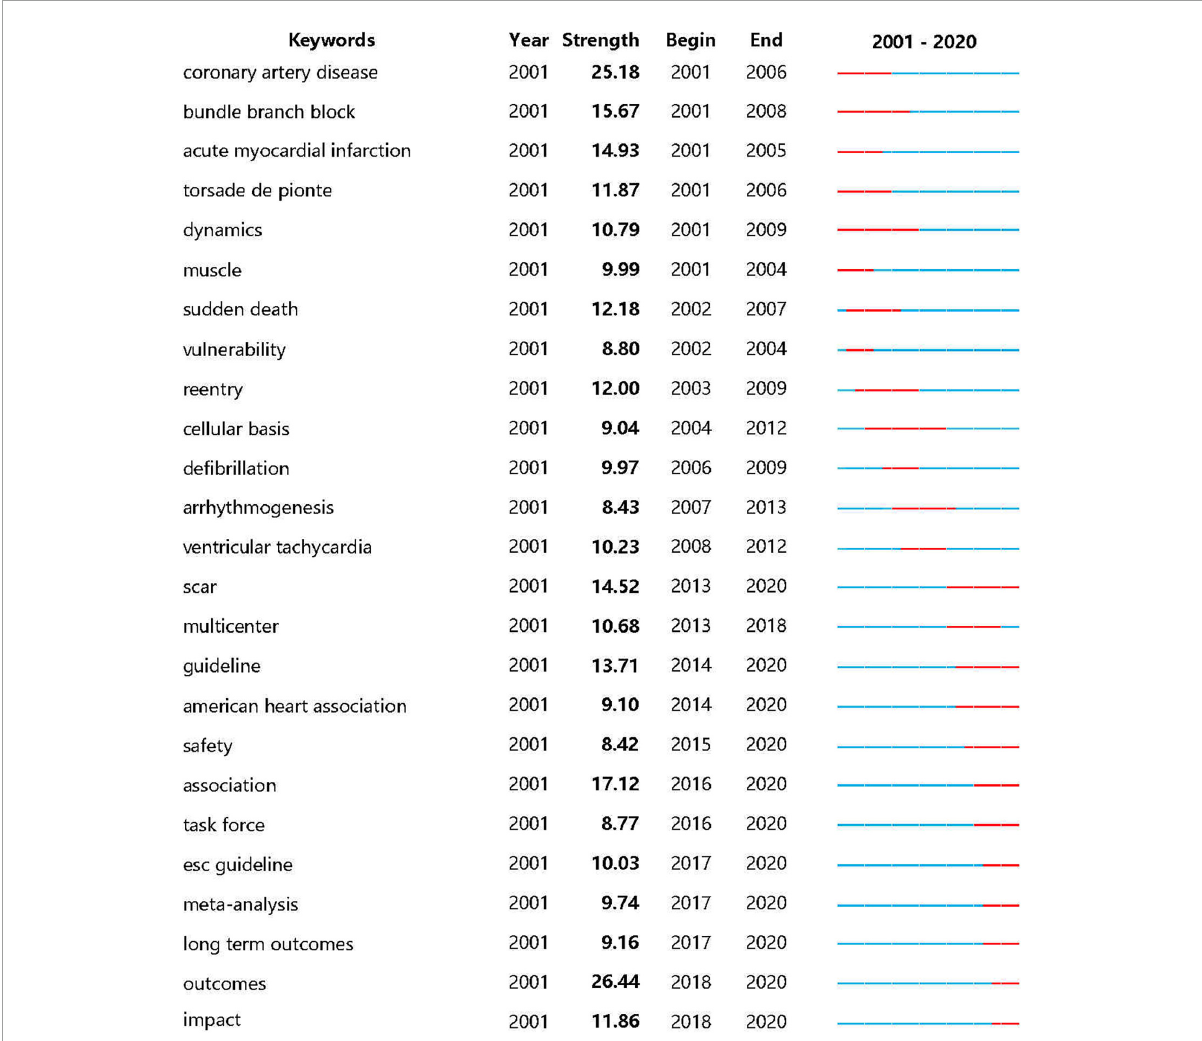
FIGURE7 Burst detection with keywords in publications on ventricular arrhythmia research (only the top 25 keywords with the strongest citation bursts were